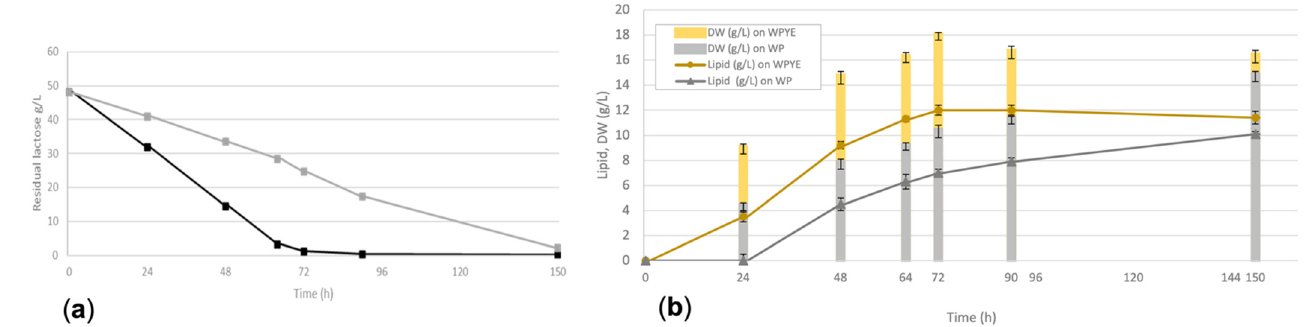
Figure 2. ( a ) Lactose utilization on WP (gray line) and on WPYE (black line). ( b ) Comparison between ATCC 20509 growth on WP and WPYE.